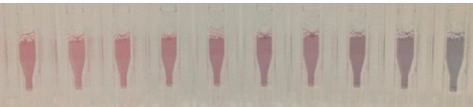
Figure 5. Color changes of AuNPs-1 suspension (Tris-HCl 0.01 M, pH 7) in the presence of increasing amounts of formaldehyde (from left to right, 0 µM, 25 µM, 50 µM, 75 µM, 100 µM, 200 µM, 400 µM, 600 µM, 1 mM, 10 mM).